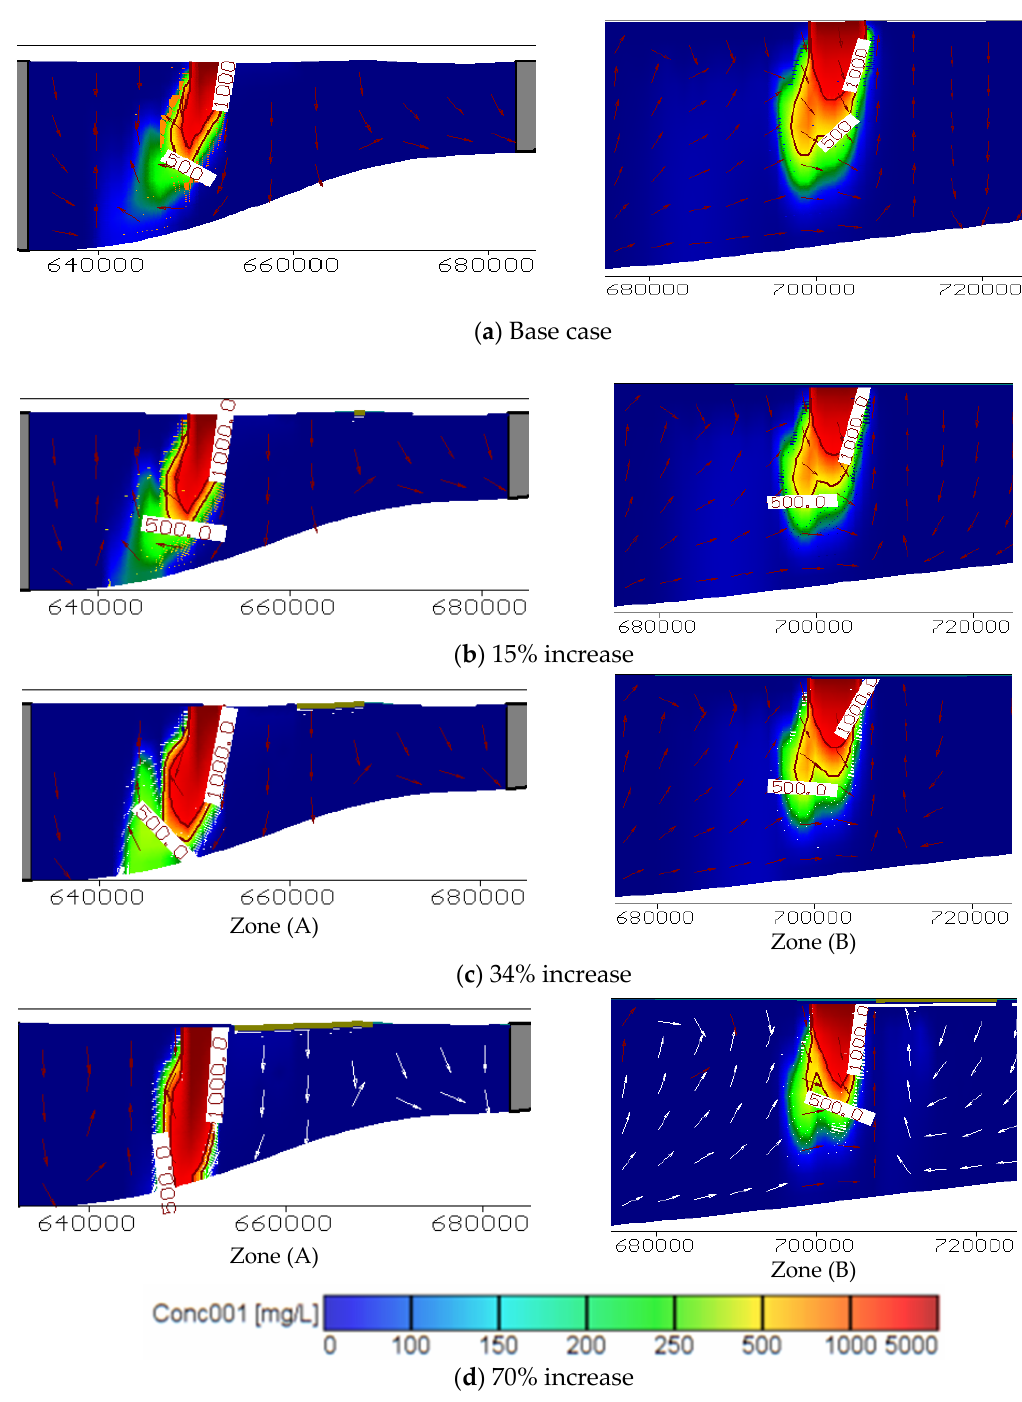
Figure 8. Vertical distribution of TDS in zones A and B for all scenarios of abstraction in the X di- rection.